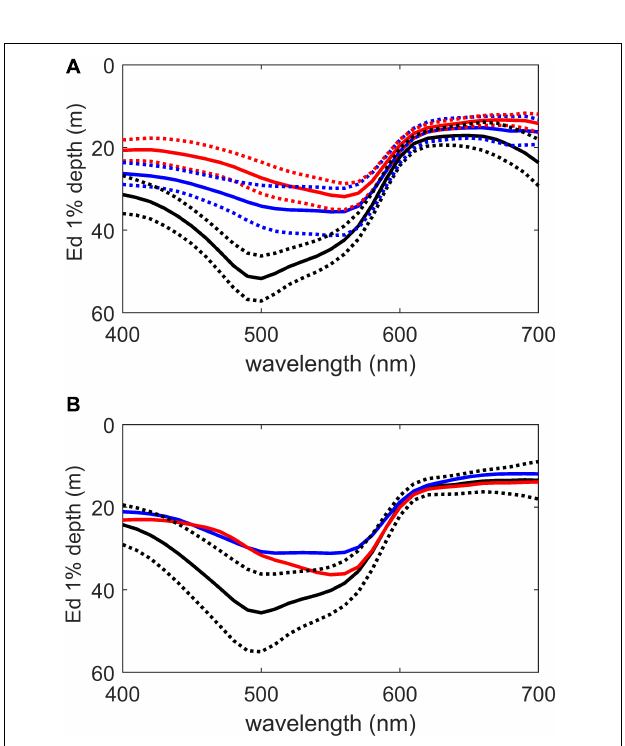
FIGURE 8 | Spectral types of 1% downwelling irradiance (E d ) in the Vaigat-Disko Bay (A) and Godthabsfjord (B) . U shaped (blue) spectral type with 500–560 nm, V shaped (red) spectral type with 560 nm and V shaped (black) spectral type with 500 nm penetrating deepest in the water column.